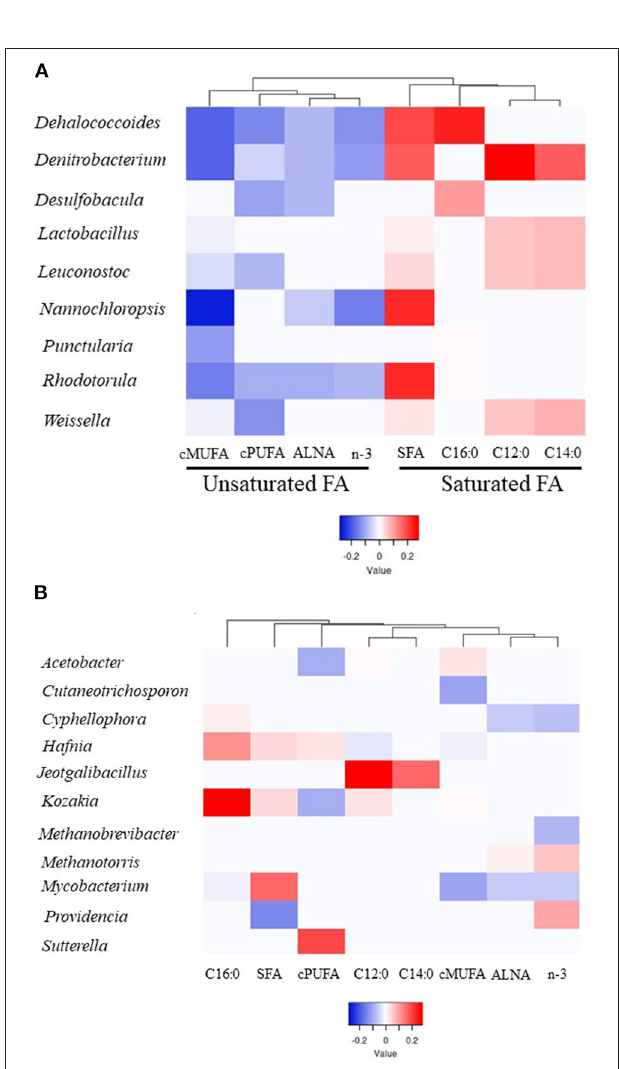
FIGURE 2 | Heatmap of the microbial genera indicating their partial least square coefficient for each fatty acid. (A) Unsaturated or saturated FA groups correlated with a particular genus. (B) Individual FA groups correlated with a particular genus. Blue color indicates a negative PLS coefficient between the genus and the fatty acid, whilst red indicates the opposite.